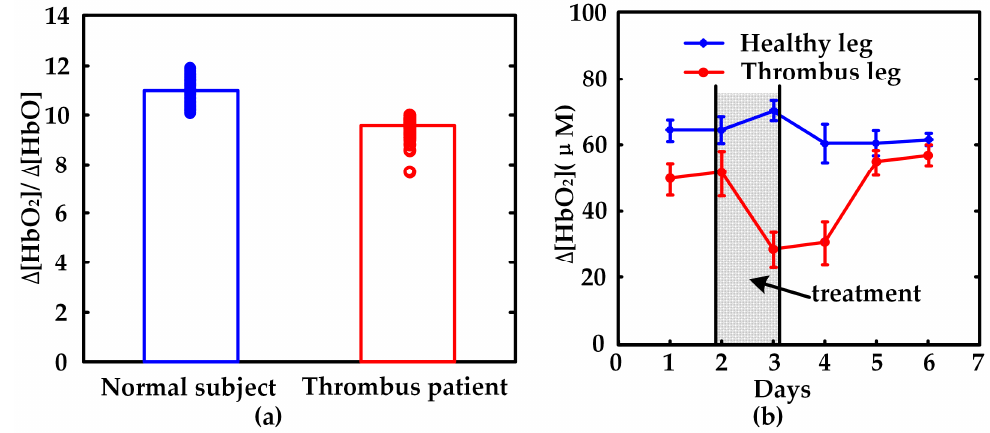
Figure 6. Measurements on thrombus clinics: ( a ) comparison of ∆ [HbO 2 ]/ ∆ [Hb] between normal subjects and thrombus patients; ( b ) the variation of ∆ [HbO 2 ] along with days between healthy leg and thrombus leg.